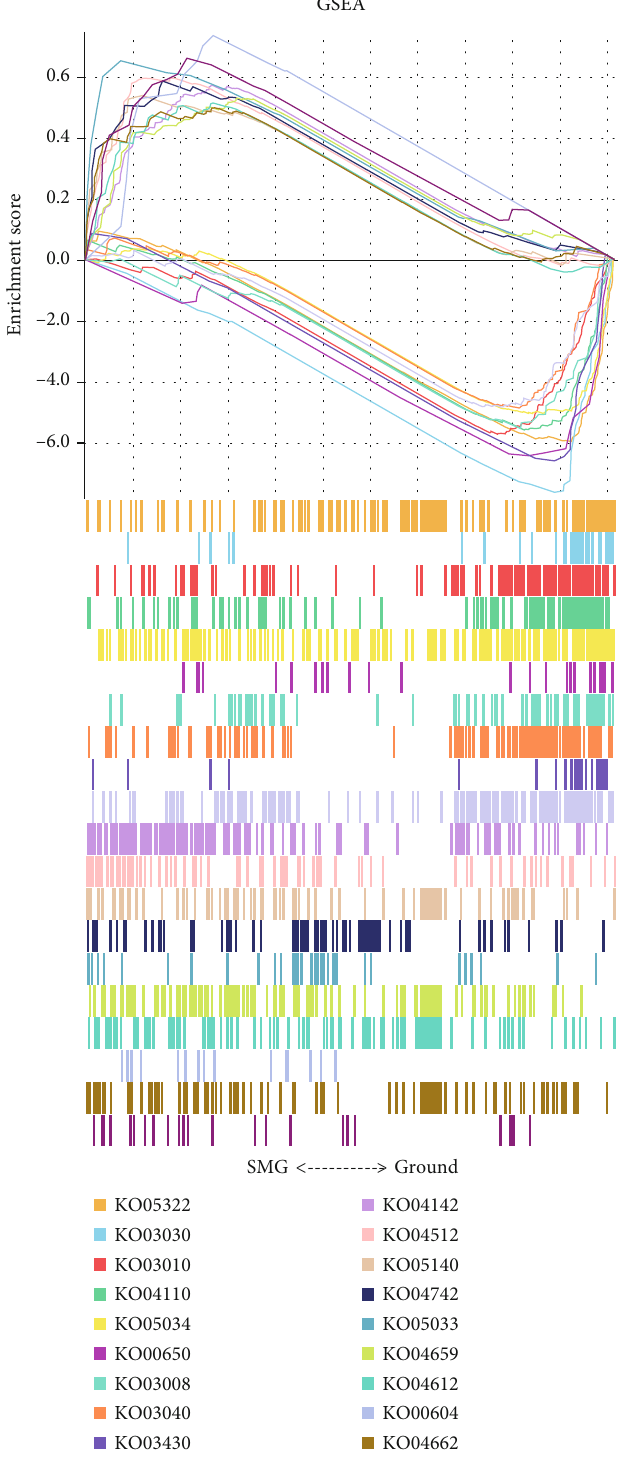
Figure 5: GSEA analysis results of